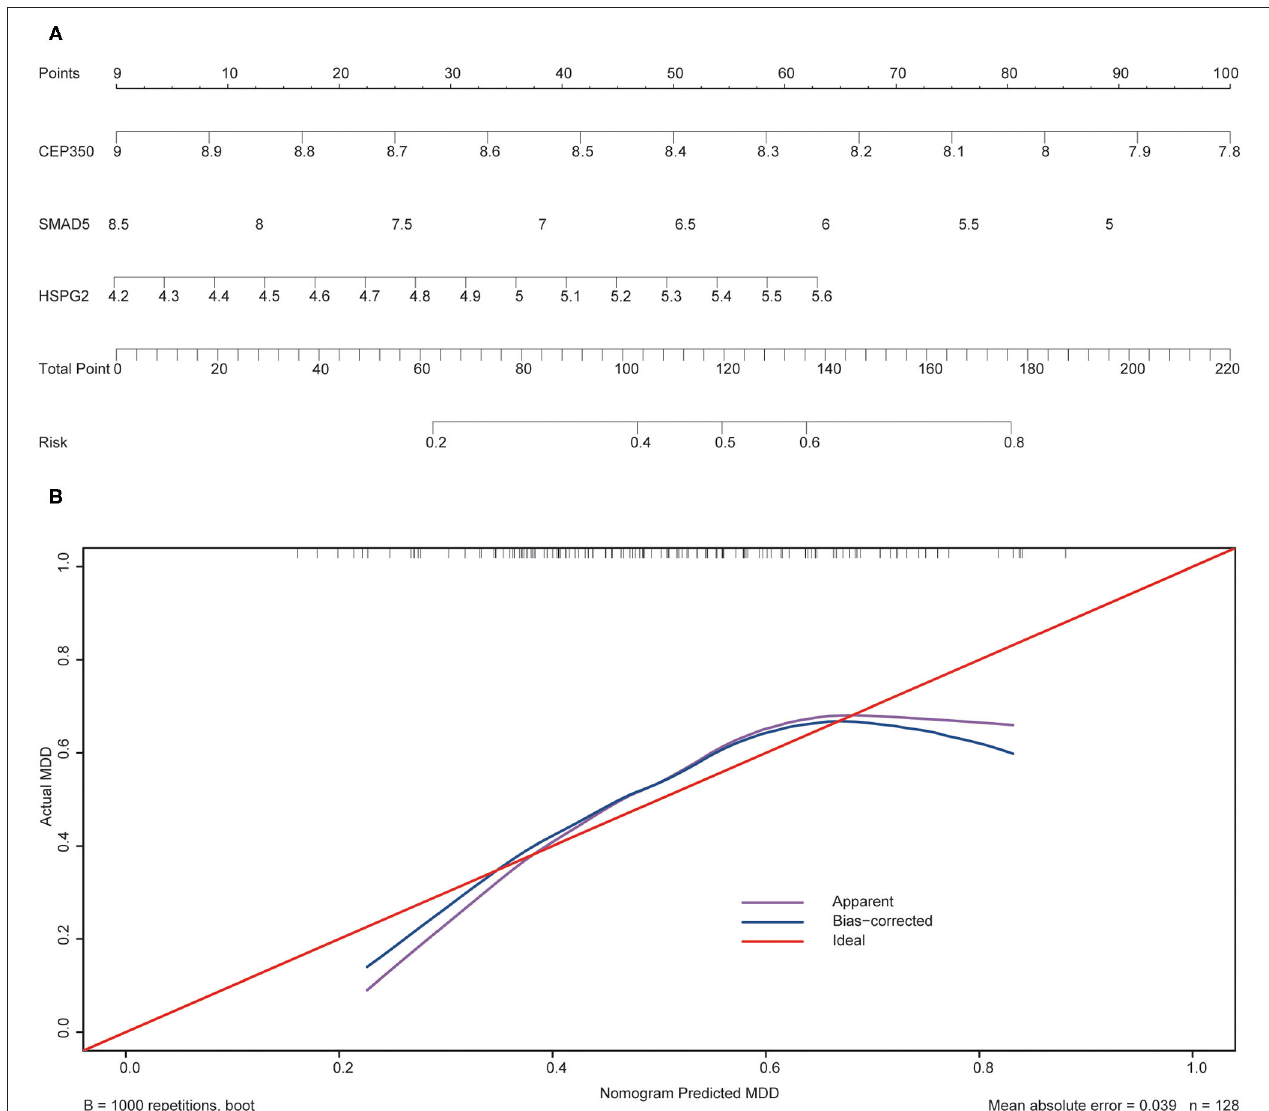
FIGURE 6 | The nomogram and calibration of combination of three hub genes (CEP350, SMAD5, HSPG2) in GSE98793. (A) Nomogram of three hub genes: the value in points line is matched with the value in lines of the genes based on their expression. Total points line refers to the sum of the matched points of these genes. And the risk range line is matched with the corresponding range in total points line; (B) Calibration of combination of the three genes: the apparent line is along with ideal line, and Hosmer-Lemeshow Test showed that there is no significant difference between ideal line and apparent